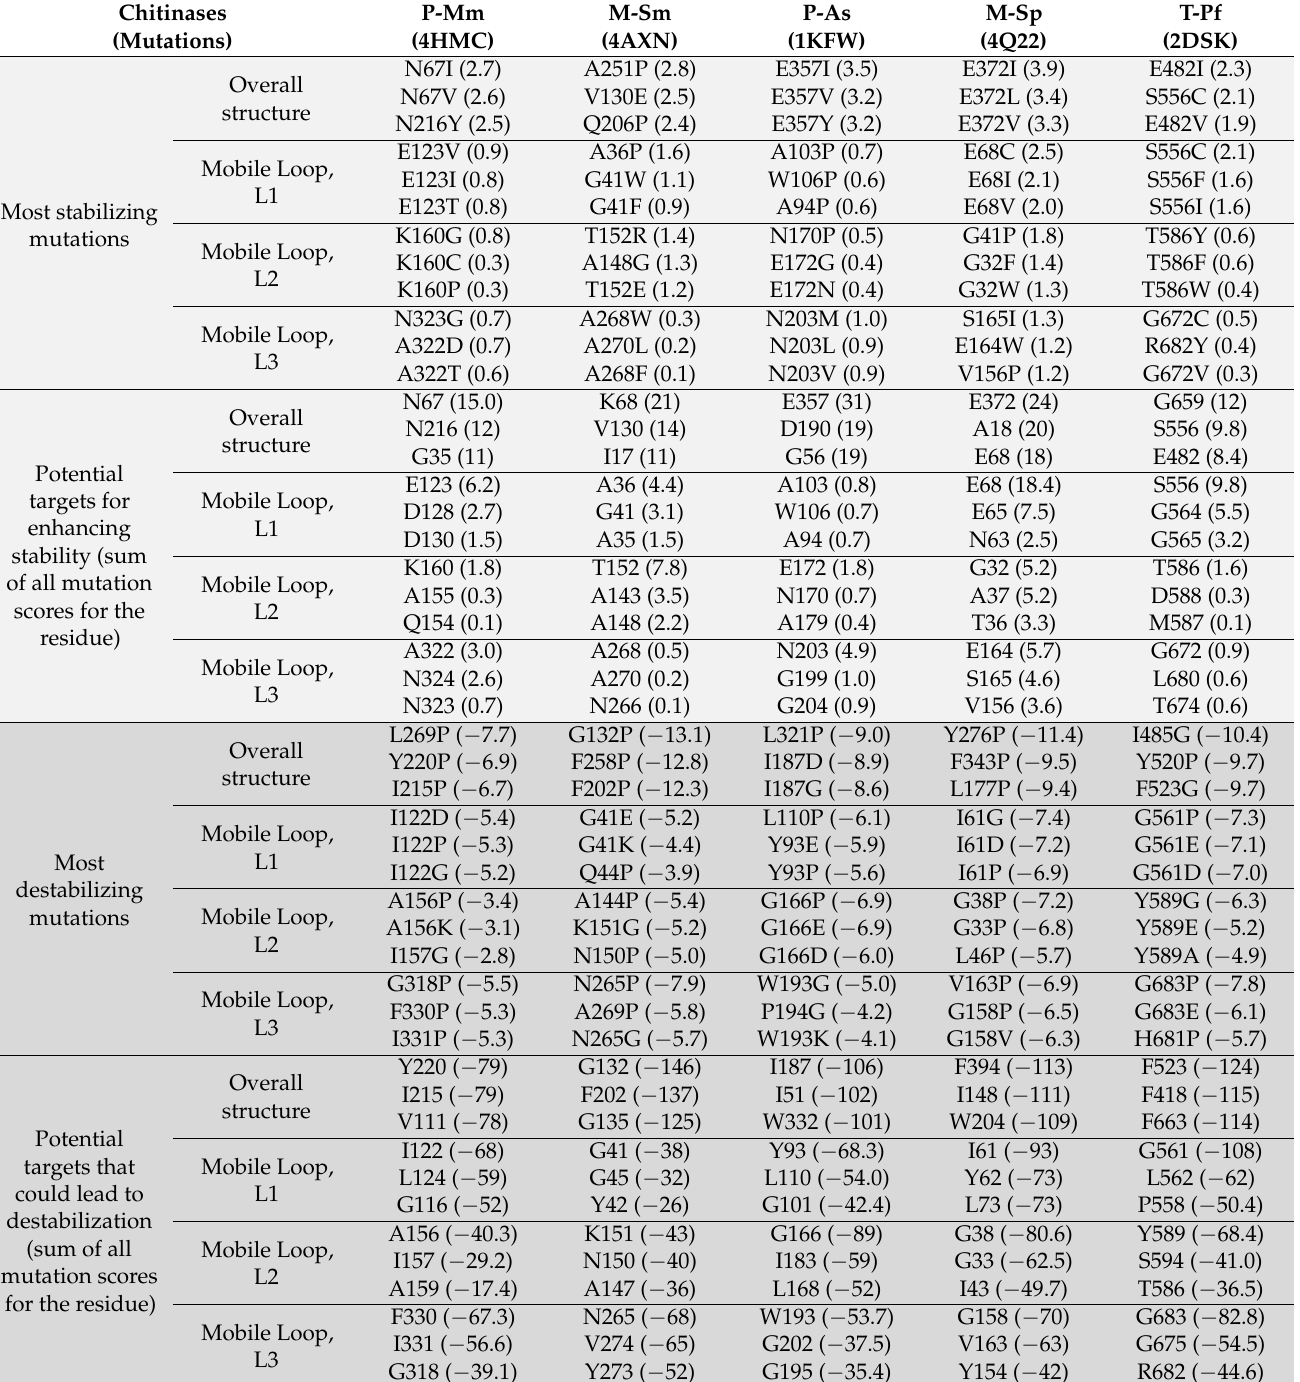
Table 2. Prediction of the stabilizing and destabilizing mutations in